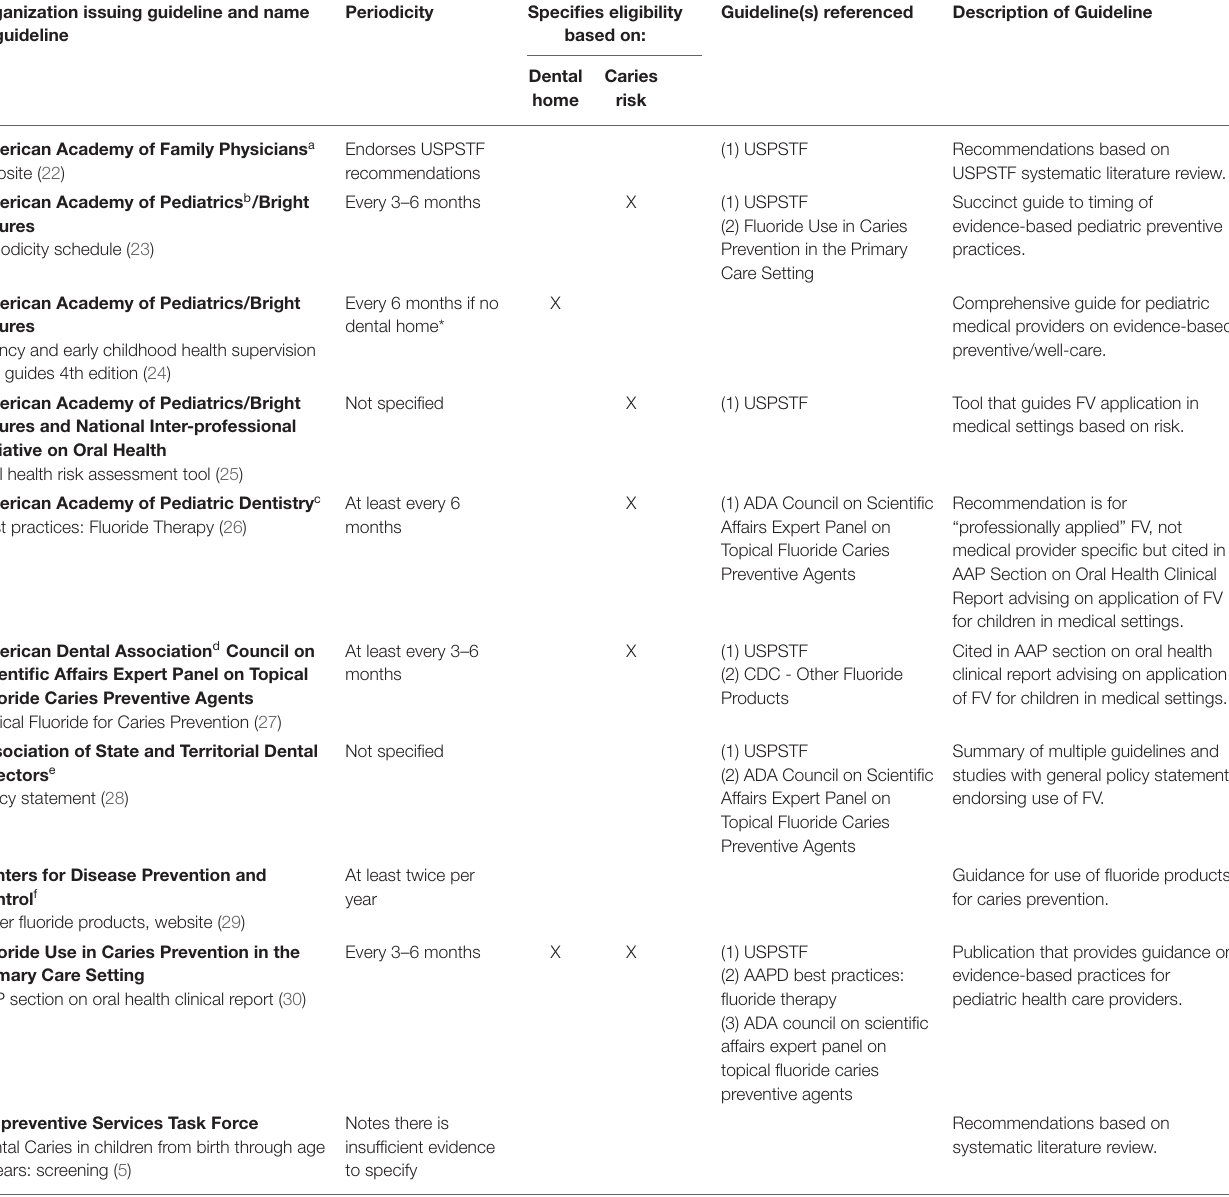
TABLE 1 | Guidelines for fluoride varnish application in medical settings for children under six years of